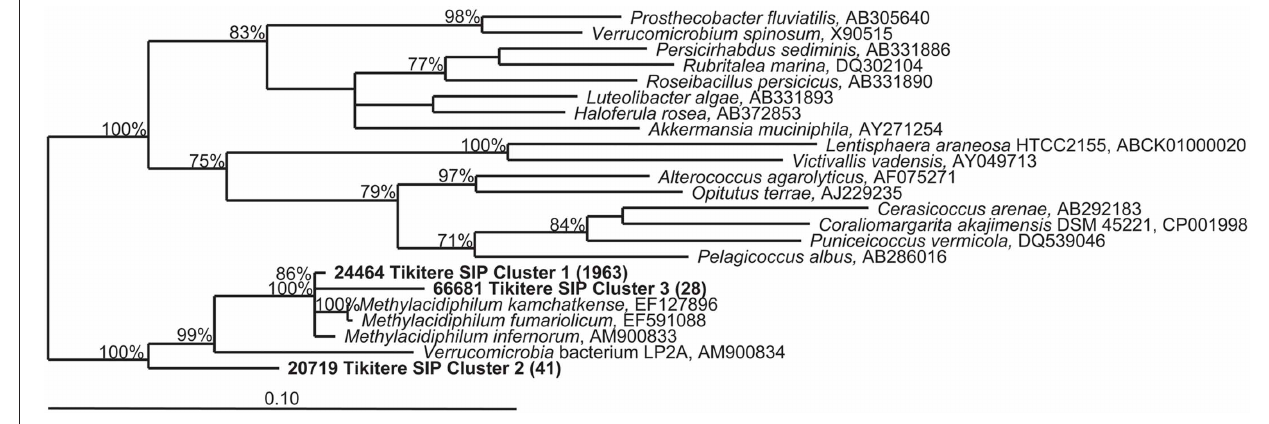
FIGURE 4 | Phylogenetic tree of partial (423 nucleotides) 16S rRNA gene sequences belonging to the Verrucomicrobia detected in the TIK5 soil sample. Representative sequences of each cluster were obtained from 16S rRNA pyrotag data using QIIME (Caporaso et al., 2010). Clusters included primarily sequences detected in the heavy DNA fractions of the 13 CH 4 + 13 CO 2 SIP experiment. The tree was constructed with